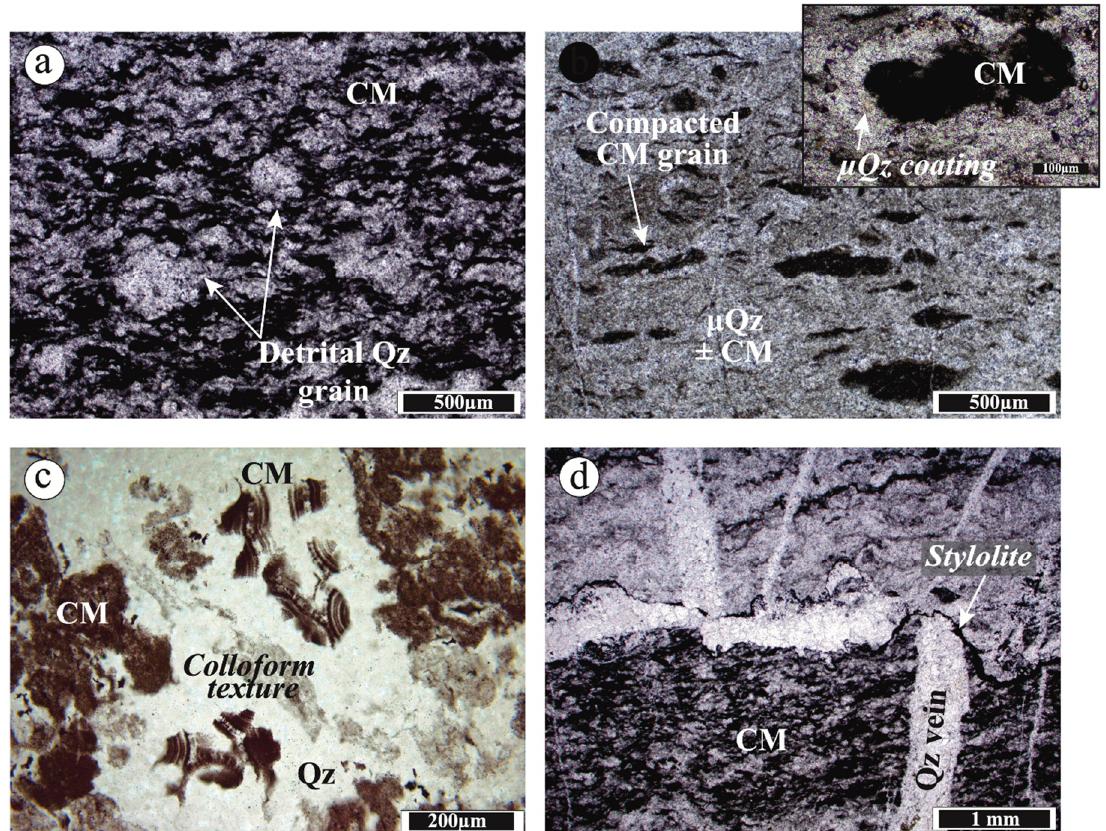
Figure 9. ( a ) and ( b ) Photomicrographs of massive black cherts from the top of the Buck Reef sequence: microbial mat structures are absent and the chert consists of a variably packed mixture of microquartz and diffuse carbonaceous matter with trapped detrital carbonaceous grains and ghosts of detrital quartz grains. A close up ( b ) shows the typical microquartz coating around detrital carbonaceous grains. ( c ) Partial silicification within the core of a black chert layer: primary textures are erased and carbonaceous matter is locally redistributed along newly formed colloform textures. ( d ) Stylolites emplaced at the boundary between variably packed zones within a black chert. The stylolite affects chert veins and represents the latest stage of Si-rich fluid migrations (CM = Carbonaceous matter, µQz = microquartz, Qz = Quartz).